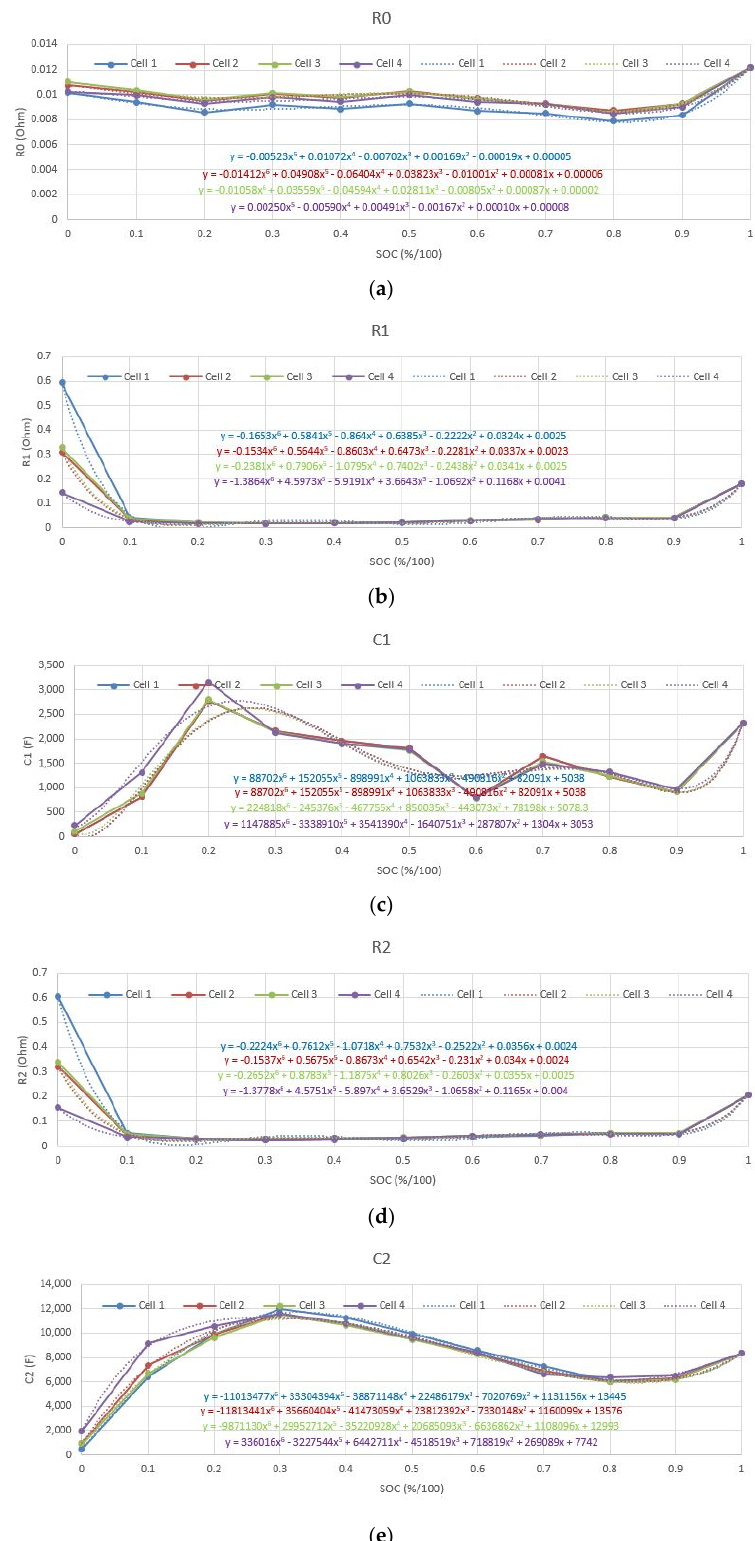
Figure A1. ECM parameter values: ( a ) R0; ( b ) R1; ( c ) C1; ( d ) R2; ( e ) C2.